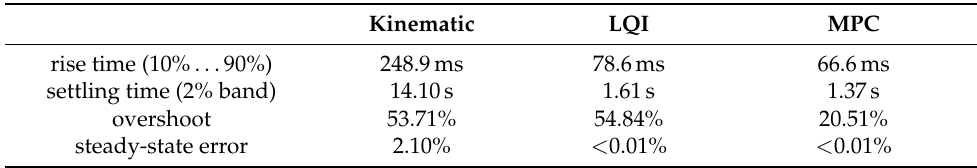
Table 4. Characteristic quantities of the step trajectory with d step = 200mm.